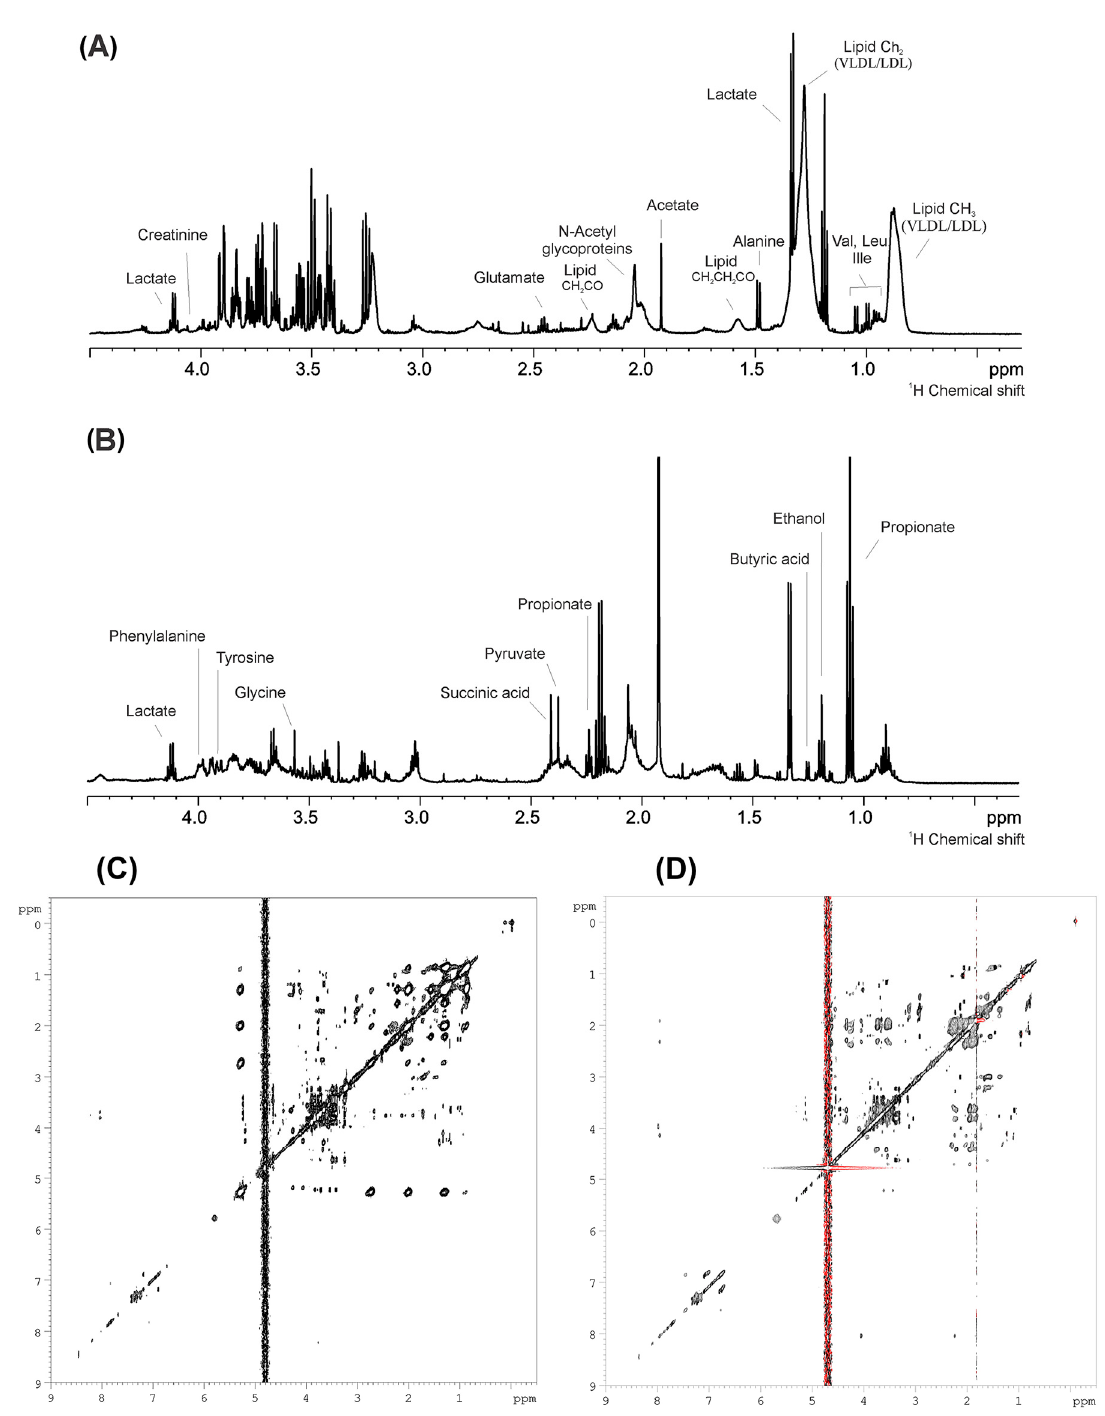
Figure 2. General view of 1D and 2D spectra of the pooled plasma (( A , C ), respectively) and pooled saliva (( B , D ), respectively)